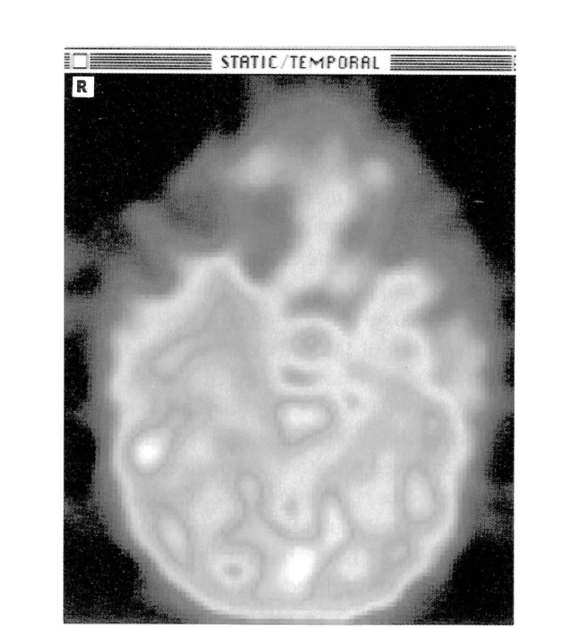
FIG. 2. Static SPECr image taken at a level through the uppertem porallobe. Relative hypoperfusion is seen in the left temporal